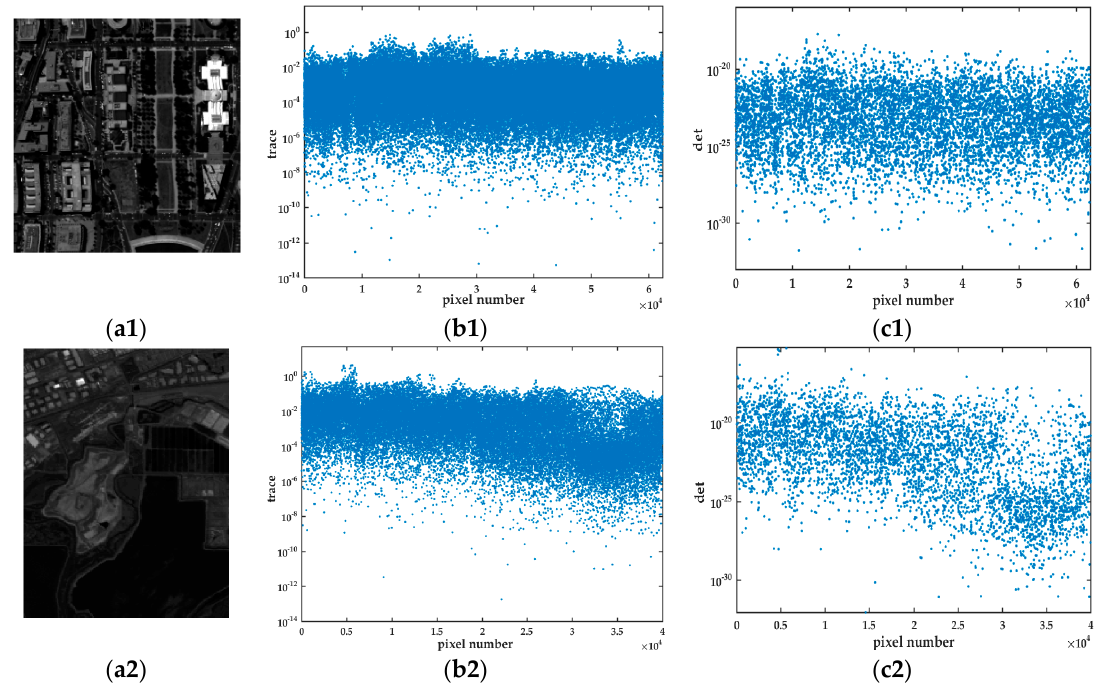
Figure 2. Trace and determinant at each pixel on two enhanced PAN images. ( a1 , a2 ) PAN image; ( b1 , b2 ) Trace of structure tensor at each pixel; ( c1 , c2 ) Determinant of structure tensor at each pixel.